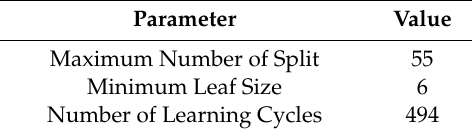
Table 4. Tuned parameter for random forest-based system.